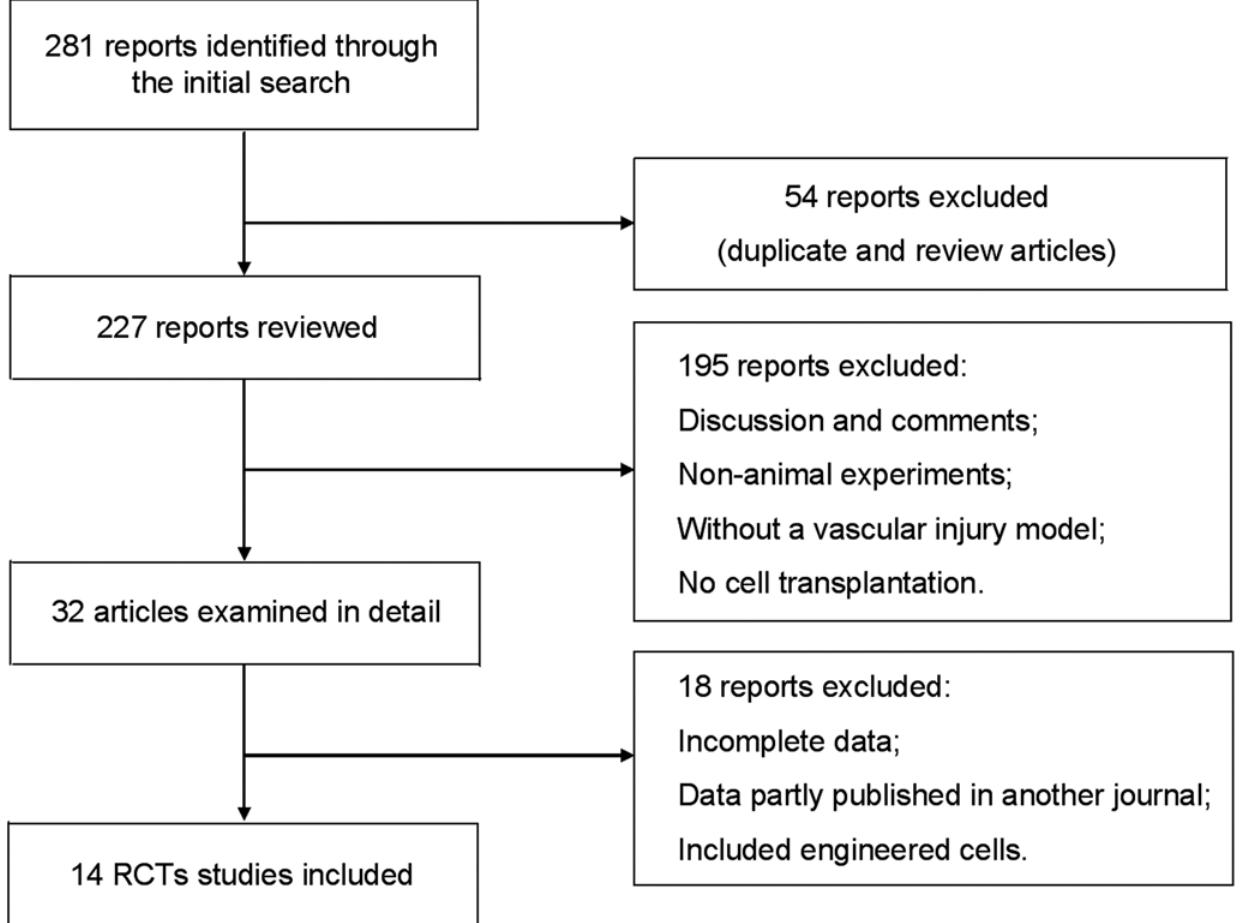
Fig 1. Flowchart of studies included in the meta-analysis of animal studies investigating mesenchymal stem cell therapy. Abbreviations: RCTs = randomized controlled